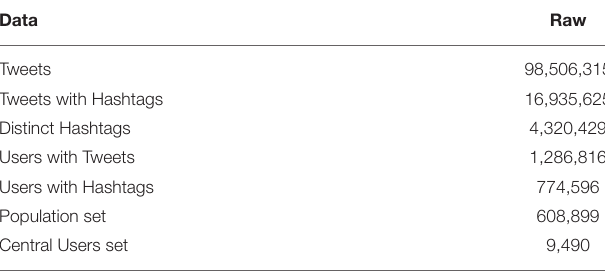
TABLE 1 | Summary of crawled